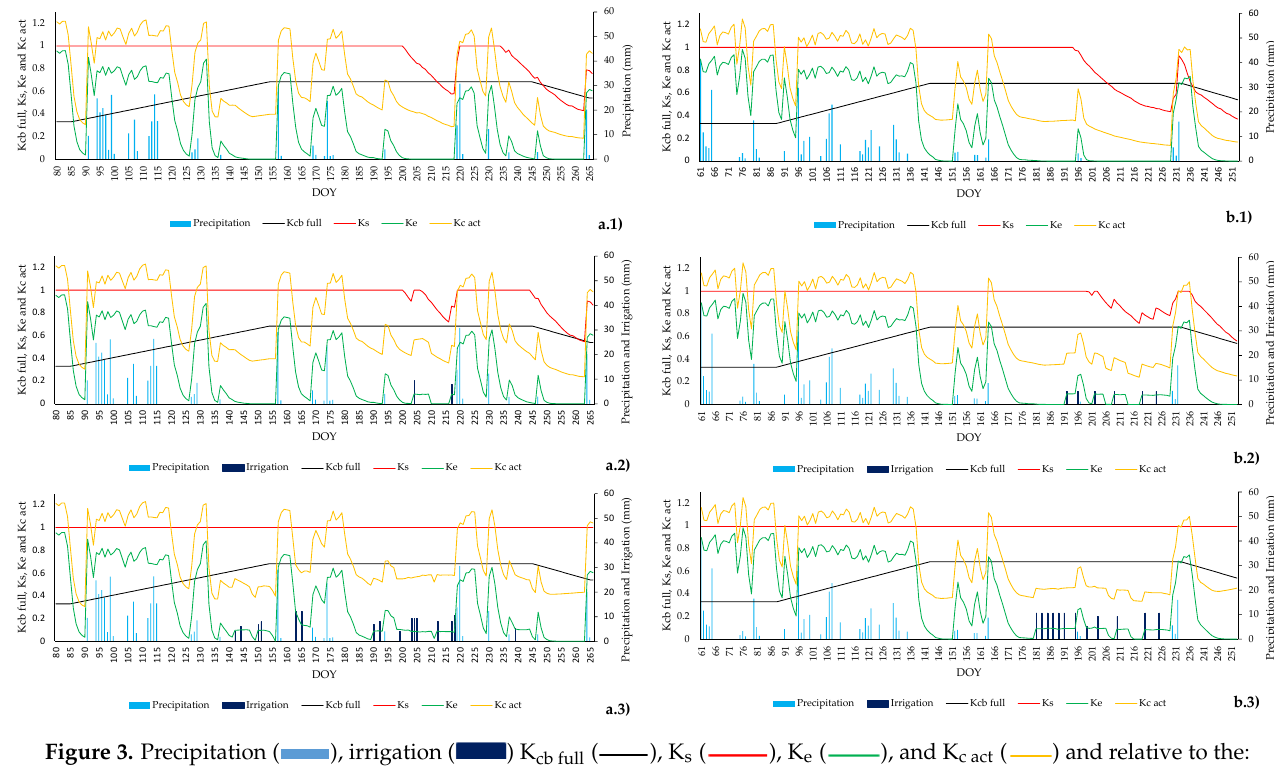
Figure 3. Precipitation ( ), irrigation ( ) K cb full ( ), K s ( ), K e ( ), and K c act ( ) and relative to the: ( a ) year 2019, ( b ) year 2020; (1) rainfed (R), (2), deficit irrigation (DI), (3) full irrigation (FI).